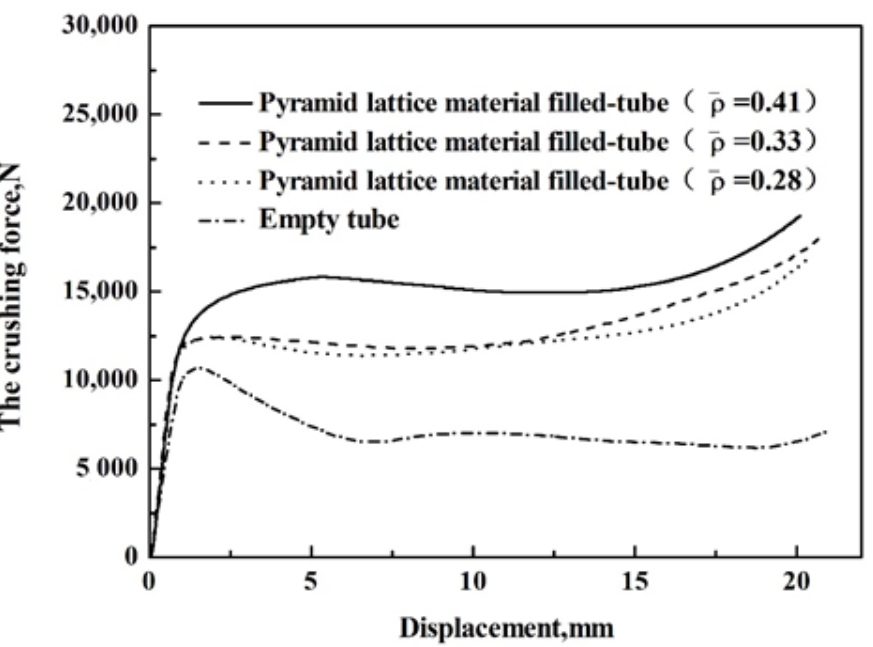
Figure 12. The average crushing force-displacement curves of the pyramid lattice material with different relative densities.